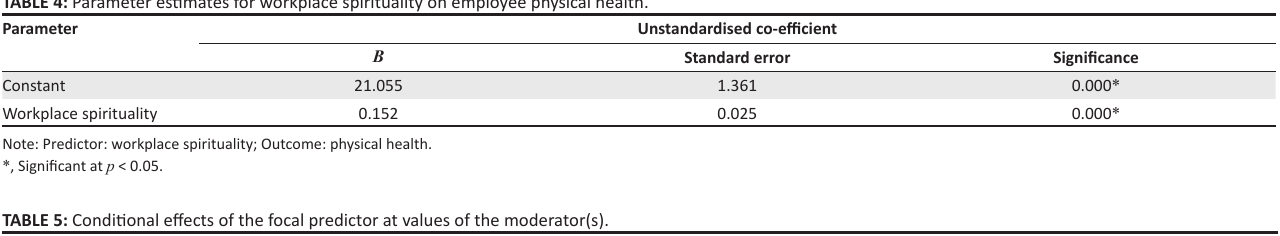
TABLE 5: Conditional effects of the focal predictor at values of the moderator(s). Career